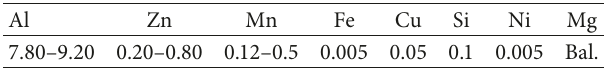
Table 1: Chemical composition of the cast AZ80 Mg alloy (wt.%).